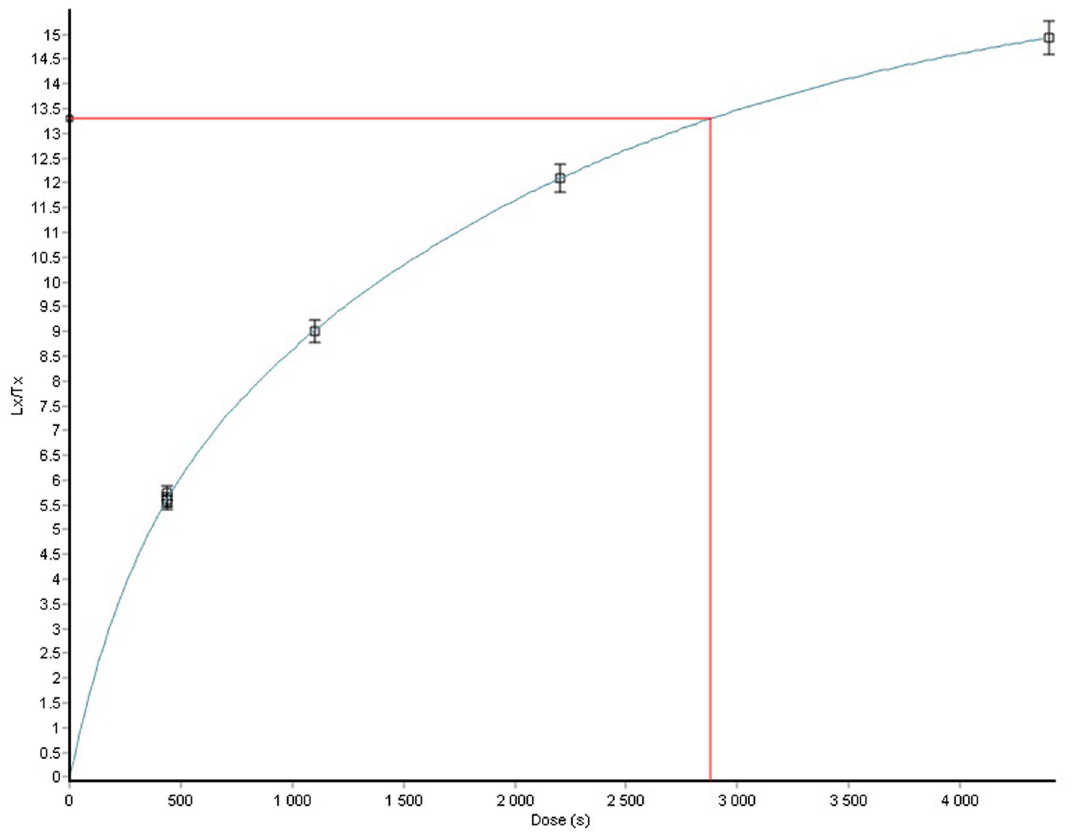
Figure 5. Dose–response curve representative of the measurements performed.